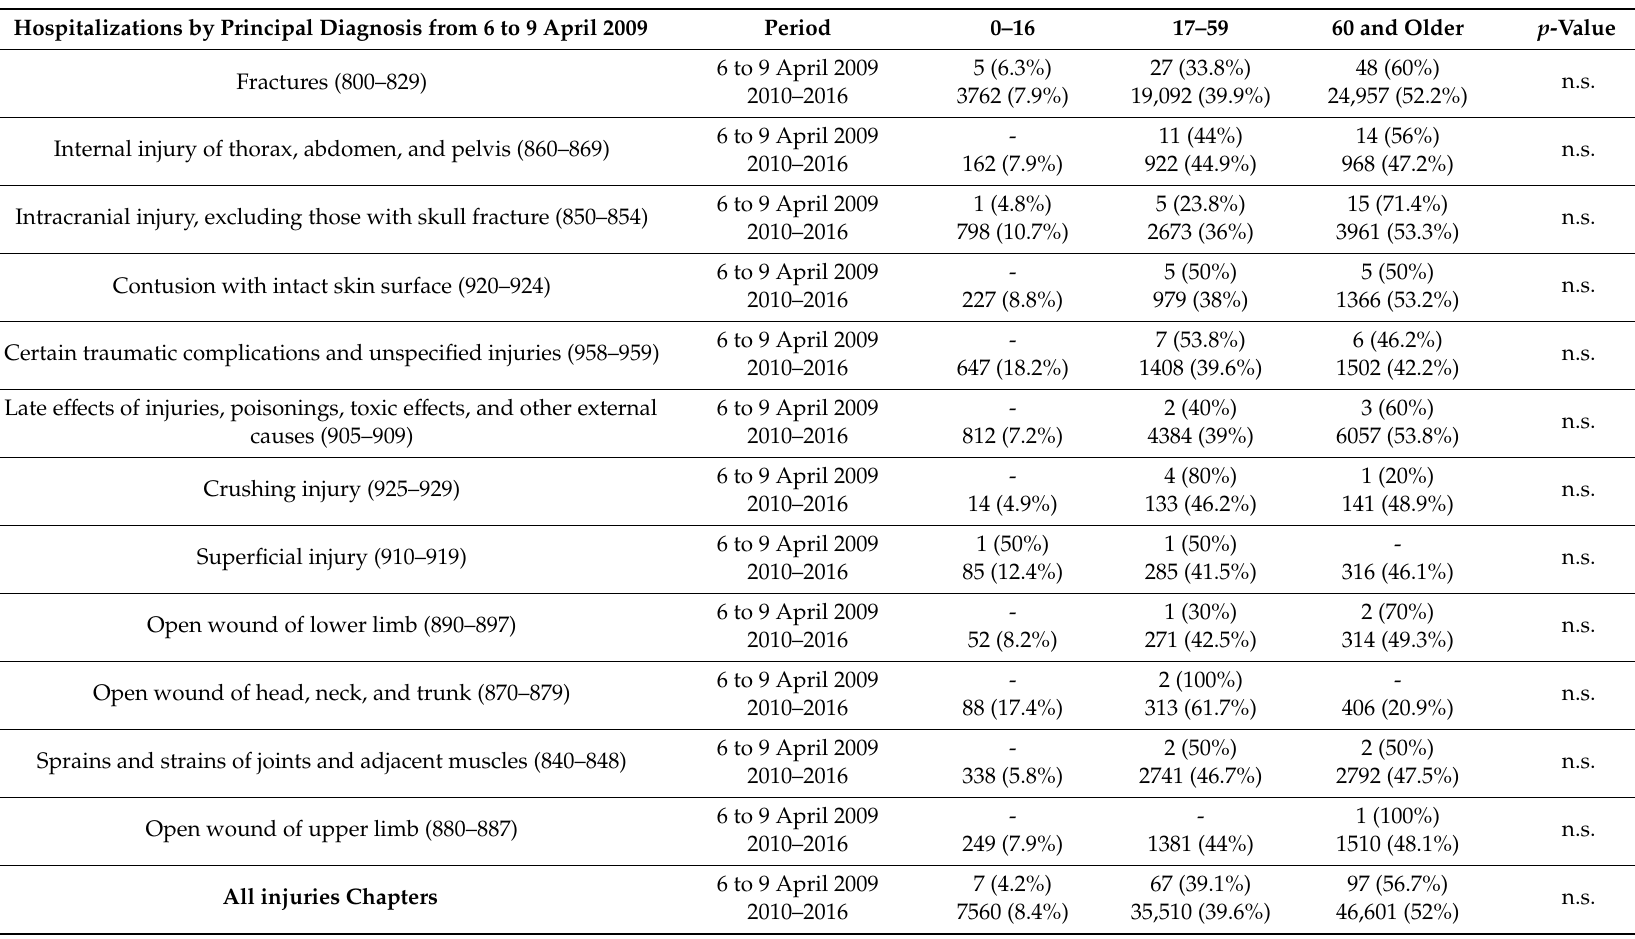
Table 6. Frequencies sorted by age among the population in the seismic crater and the overall Abruzzo population admitted to hospital due to an injury in 2009 vs. 2010–2016 period. (ICD-9-CM, Injury